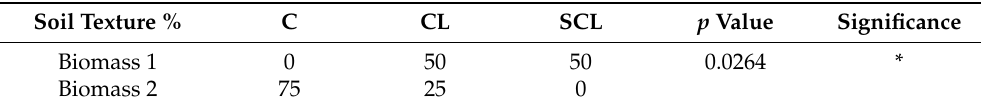
Table 2. Percentage of soil texture of the two areas. C = Clay, CL = Clay loam, SCL = Sandy clay loam. The * indicates a statistically significant difference.